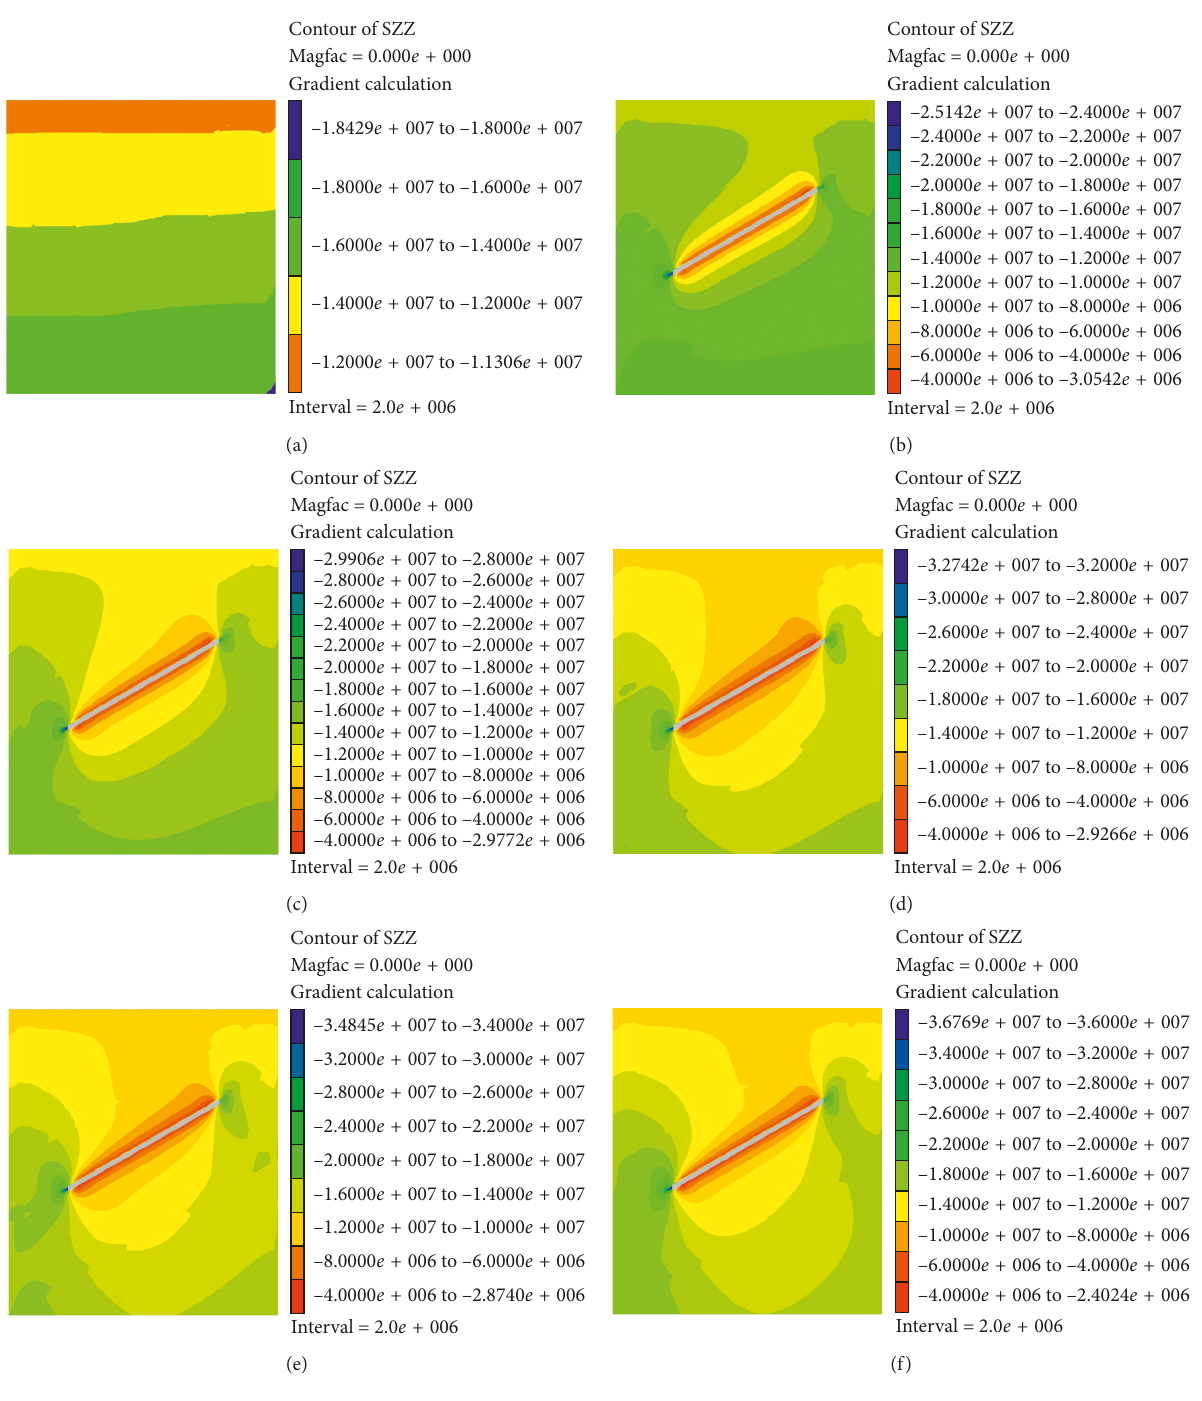
F IGURE 2: Vertical stress of workface floor along the inclined direction of the coal seam with the advancement of the workface. (a) Original vertical stress. (b) Advanced 20 m of workface. (c) Advanced 40m of workface. (d) Advanced 60m of workface. (e) Advanced 80m of workface. (f) Advanced 100m of